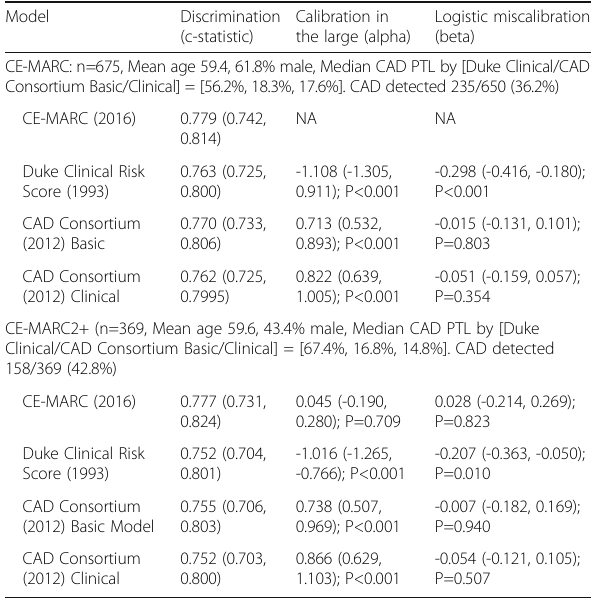
Table 1 (abstract P20). Summary of model